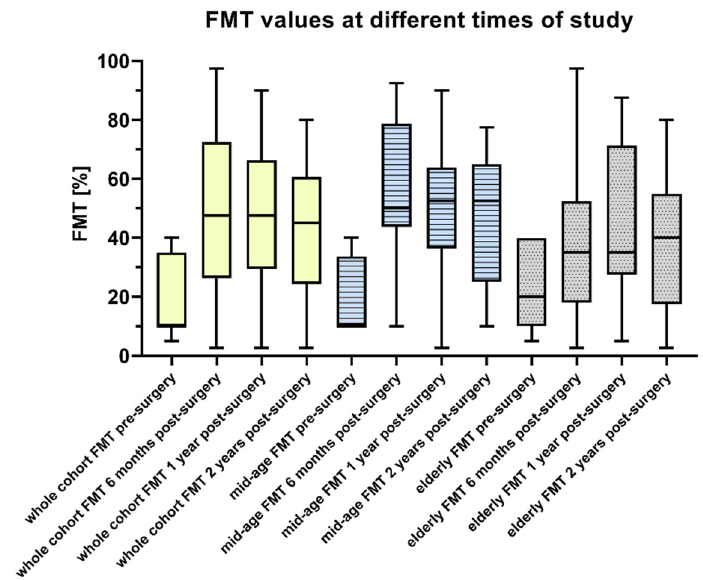
Figure 2. Speech perception measured with the Freiburg monosyllabic test (FMT). Box-and-whisker plots demonstrate the median values (box extend from the 25th to 75th percentiles) of FMT; whiskers indicate the minimum and maximum values. Shown is the FMT distribution in the whole cohort, mid-age (50–70) and elderly (>70) groups before surgery and 6, 12, and 24 months after surgery.